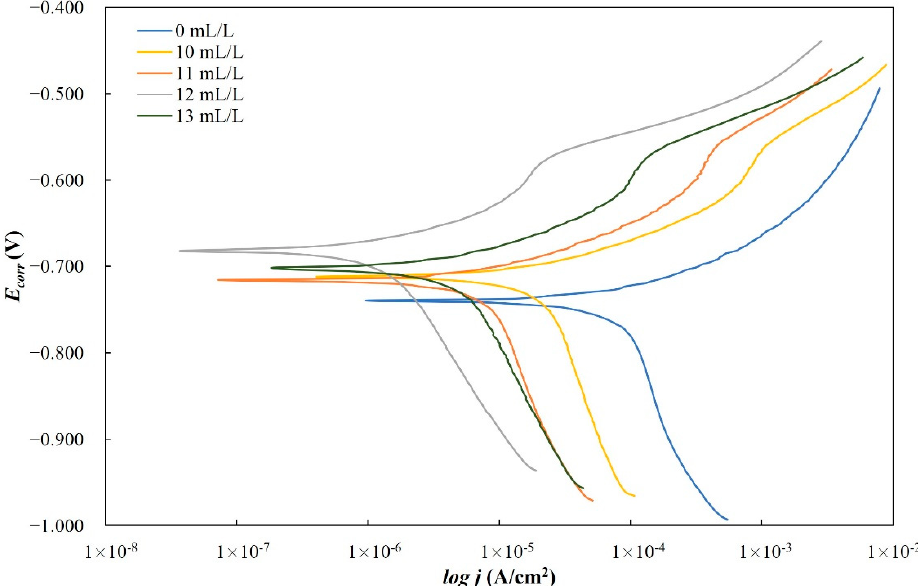
Figure 2. Polarization curves scanned on the carbon-steel sample in the simulated brine saturated with CO 2 with and without an inhibitor in static conditions (Adapted from [24]). Table 3. Electrochemical parameters determined from polarization curves scanned on the carbon ‐ steel sample in the simulated brine saturated with CO 2 with and without inhibitor in static condi ‐ tions (Data from [24]).